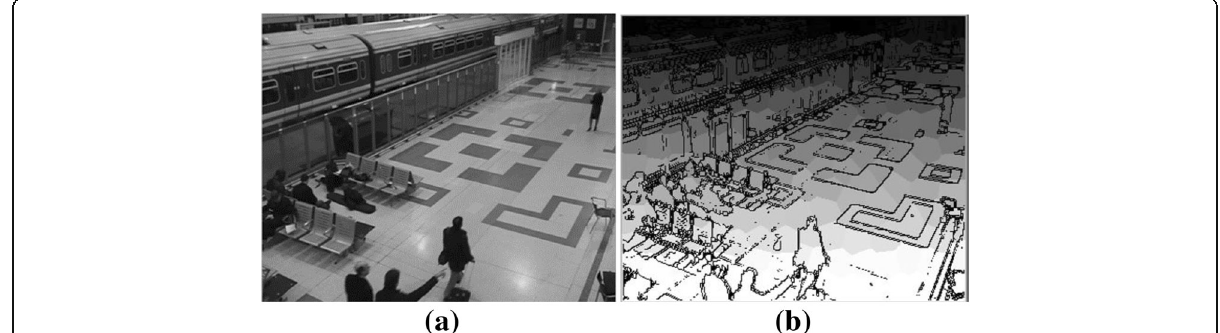
Fig. 8 Example of thinning. a Gray image. b Thinning